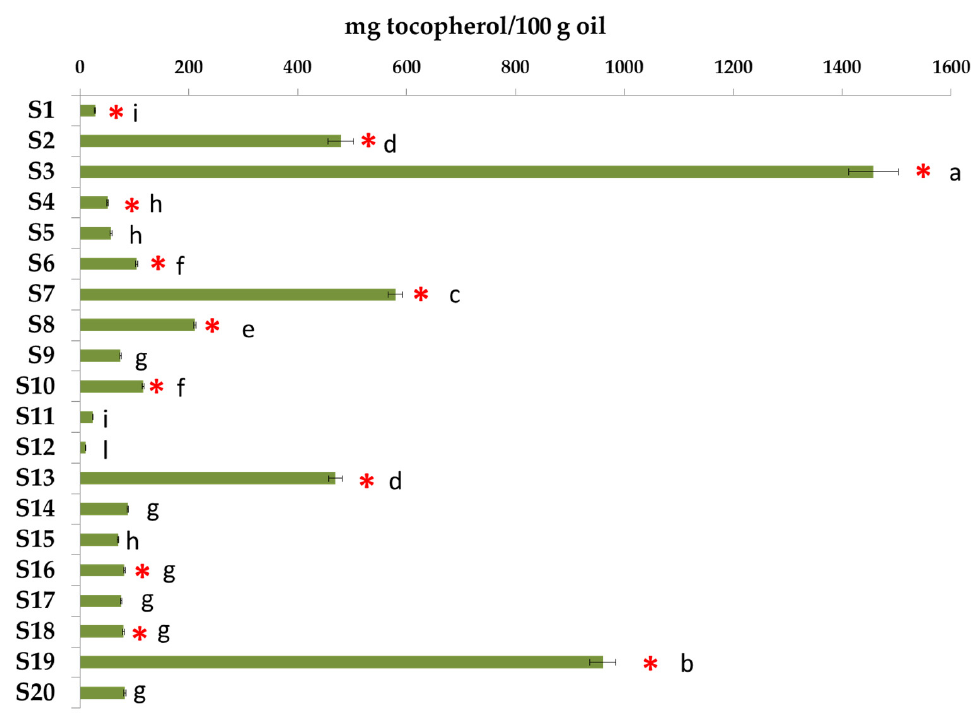
Figure 4. Total content of tocols (mg/100 g oil). Red asterisk indicates the addition of tocopherols as ingredients as reported in the label. Error bars present the standards deviation ( n = 3). Different letters report statistical differences ( p < 0.05).